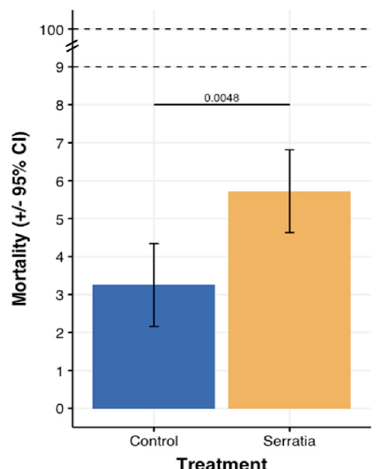
Figure 4. Larval mortality after 24 days, “Control” corresponds to the cups without the addition of Serratia to the feed while “Serratia” indicates the cups in which the bacterial culture was added to the feed at the beginning of the experiment.